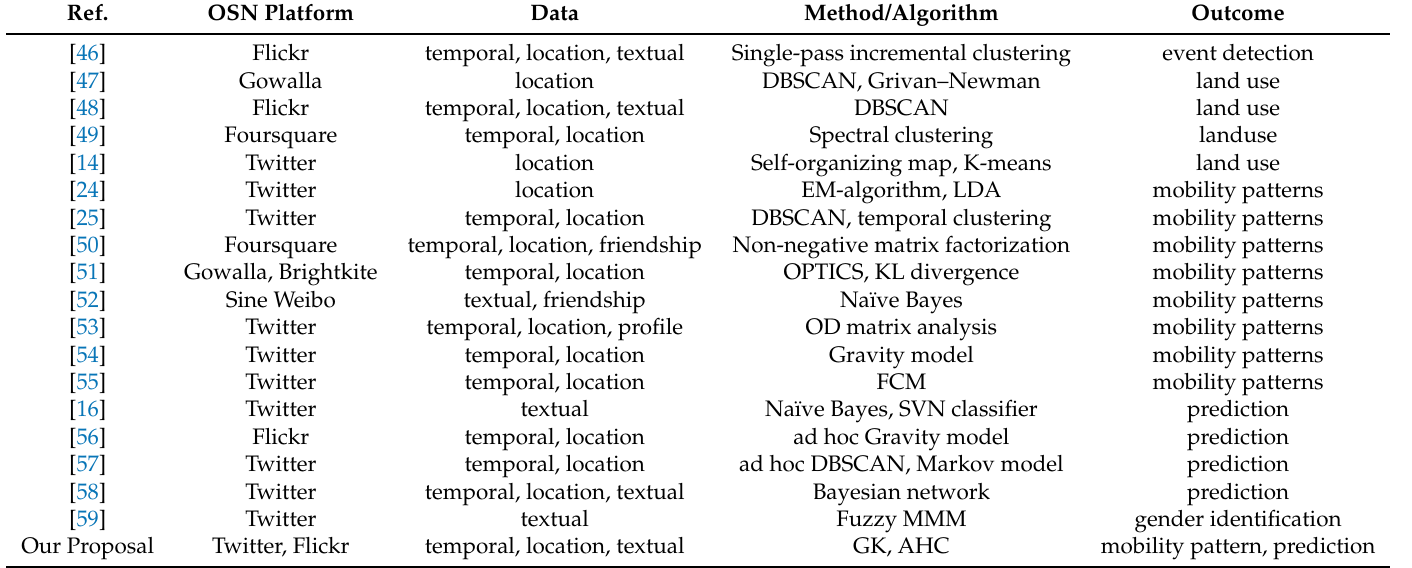
Table 11. Main features of other